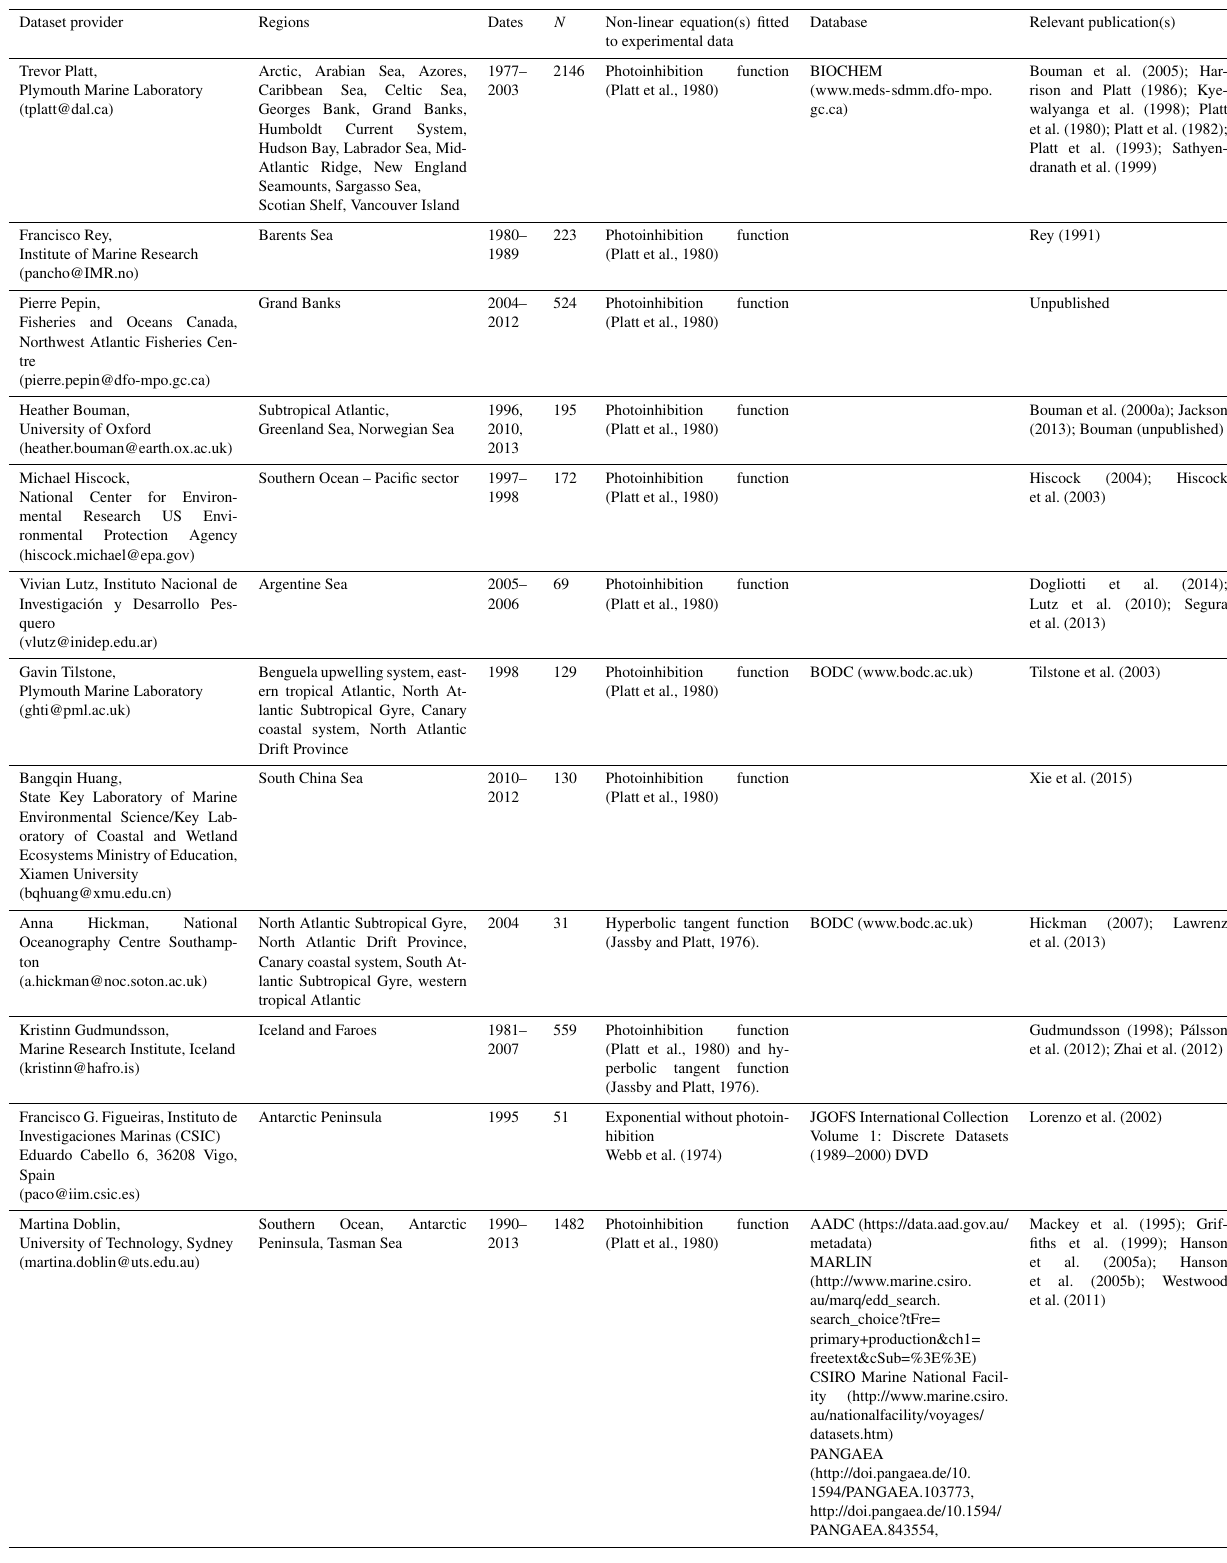
Table 2. Summary of contributions to the MAPPS